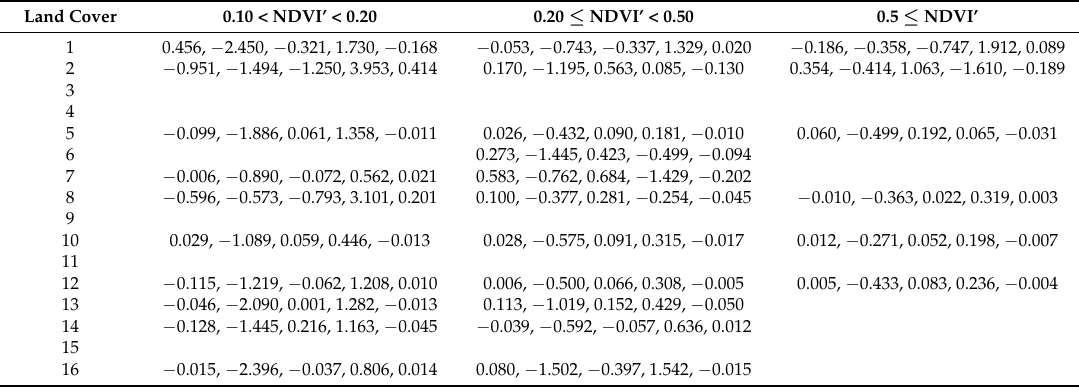
Table 2. Surface Reflectance Coefficients for 0.47 µ m for March-April-May (MAM). Land Cover 0.10 < NDVI’ < 0.20